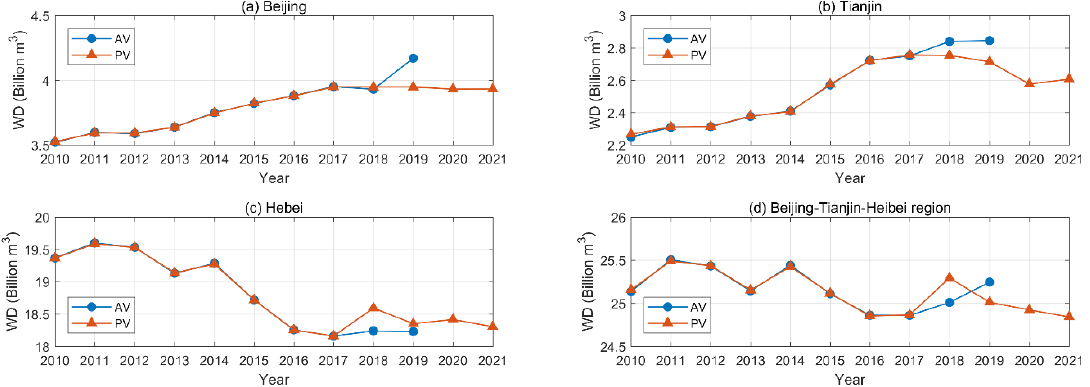
Figure 4. Actual and predicted values of water demand in ( a ) Beijing, ( b ) Tianjin, ( c ) Hebei, and ( d ) the Beijing–Tianjin–Hebei region from 2010 to 2021 (WD is the water demand, AV is the actual value, and PV is the predicted value).